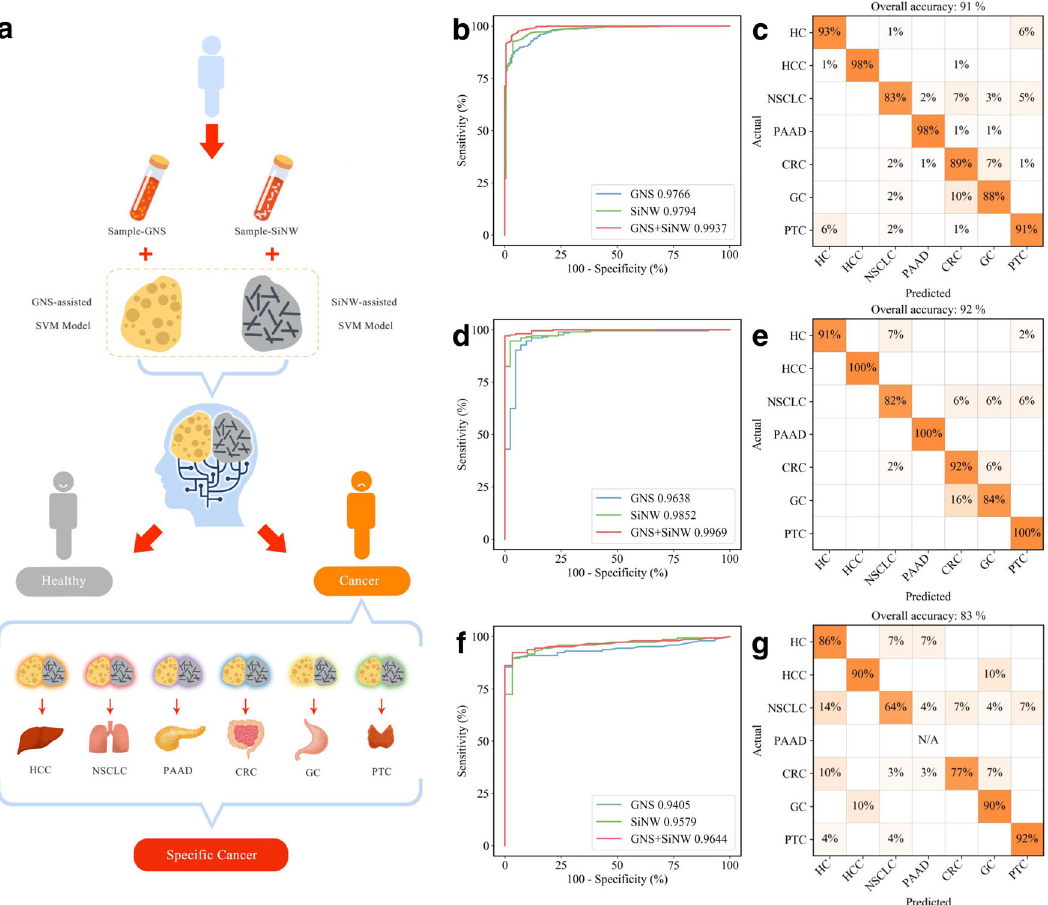
Fig. 2 Detection and classi fi cation of cancers by MNALCI. Flow Diagram for MNALCI ( a ). ROC curves with the best accuracy of the GNS-assisted SVM model, SiNW-assisted SVM model and the fusion model for distinguishing patients from healthy controls in the training cohort ( b ), internal validation cohort ( d ) and external validation cohort ( f ). Confusion matrix summarizing the cancer classi fi cation results in the training cohort ( c ), internal validation cohort ( e ) and external validation cohort ( g ) using the fusion